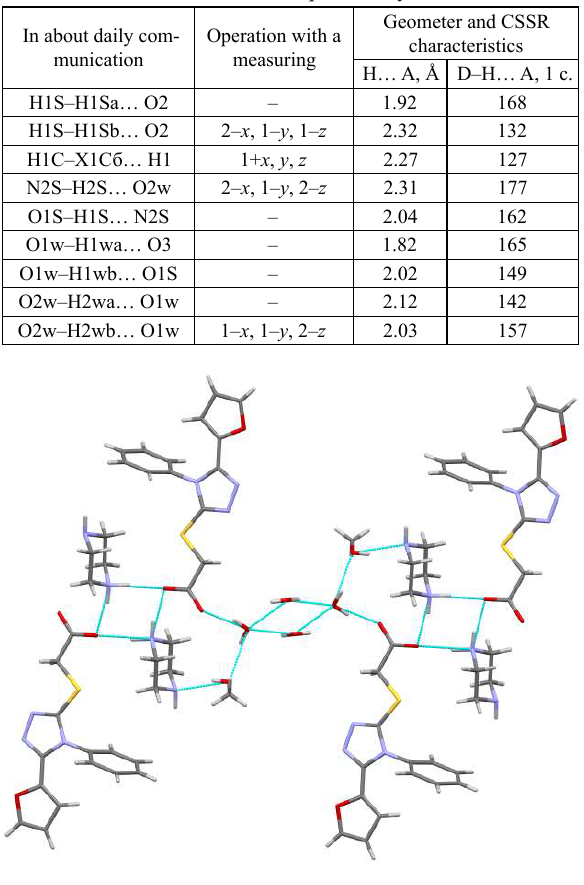
Fig. 3. Tetramers of two cations and two anions bound